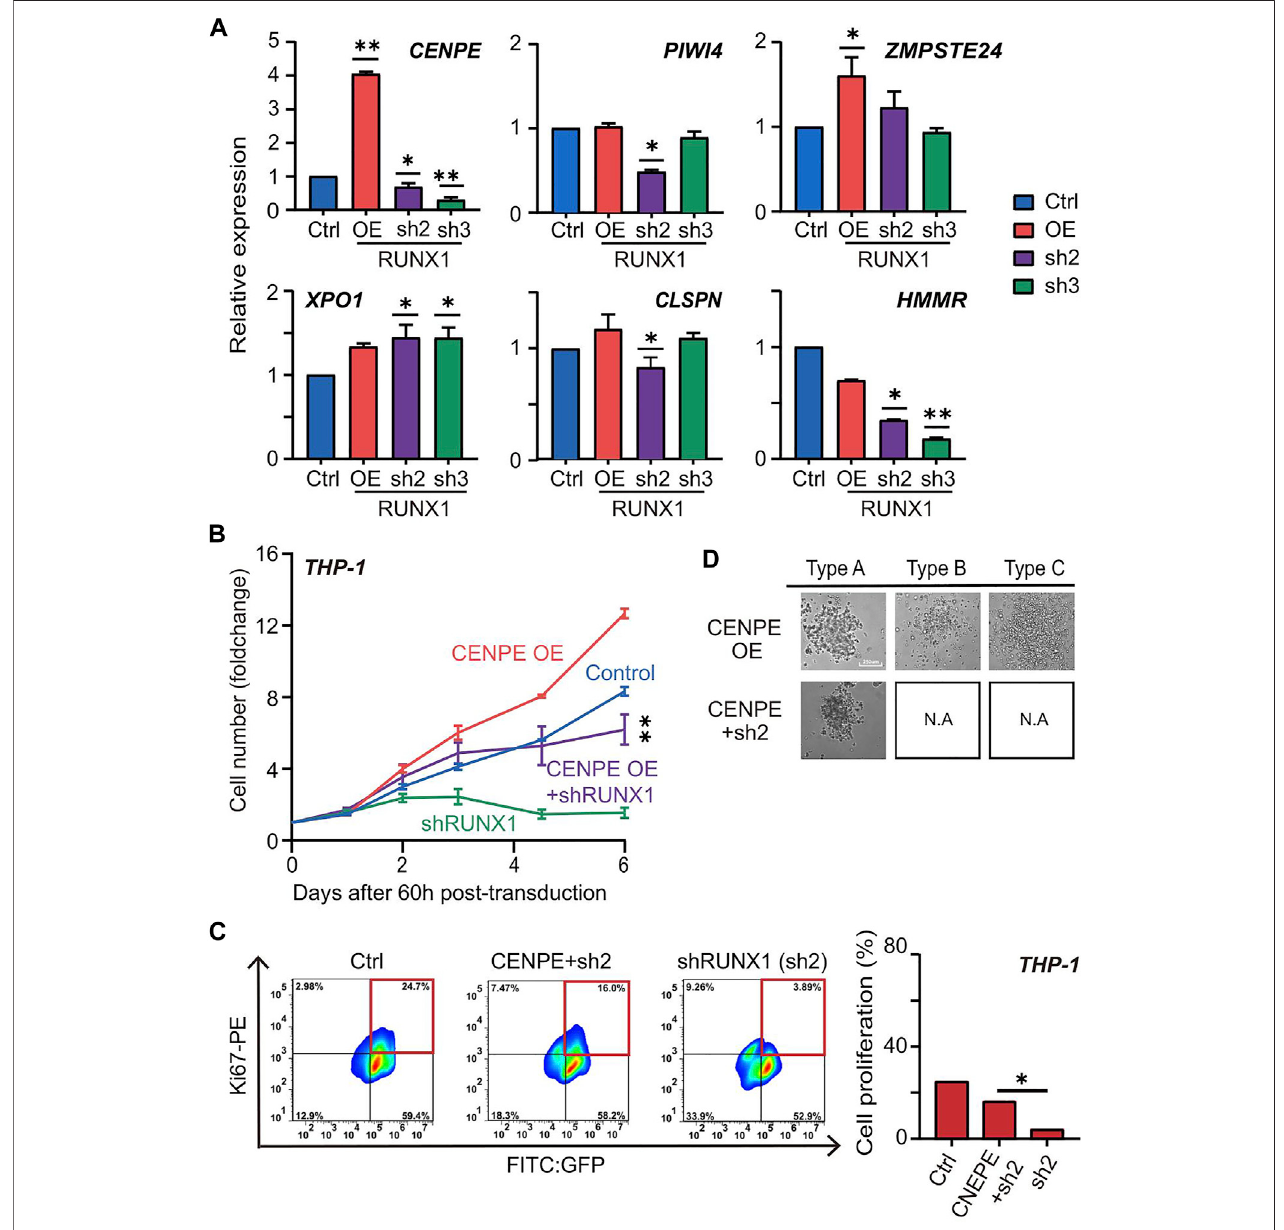
FIGURE 5 | RUNX1directlyregulatesCENPEcanrescuecellproliferation. (A) qRT-PCRcon fi rmedtherelativemRNAexpression(CENPE,PIWI4,ZMPSTE24,XPO1, CLSPNandHMMR)ofTHP-1cellswithemptyvector,RUNX1andRUNX1shRNA invitro . (B) GrowthcurveofTHP-1cellsthatrescuedwithCENPE.GrowthcurveofTHP-1 cells that contained different groups. Blue trace is the empty vector control. Orange and green are cells transfected with individual CENPE and shRUNX1, respectively. The purple trace is transfected with CENPE in RUNX1 knockdown of THP-1 cells. (C) FC analysis of cell proliferation in THP-1 cells treated with Control, shRUNX1, and shRUNX1+ CENPE. (one-way ANOVA, * p < 0.05, ** p < 0.01,*** p < 0.001; error bars, median ± SD). (D) The colony subtypes of THP-1 cells after transduction of CENPE (labeled as CENPE OE) and CENPE + shRUNX1 (labeled as CENPE + sh2) were observed under the microscope [control (labeled as Ctrl) and shRUNX1 (labeled as sh2) conditions are shown in Figure 3B , but not shown here to avoid redundancy]. Supplementary Figure S9 shows images for all conditions in triplicate.